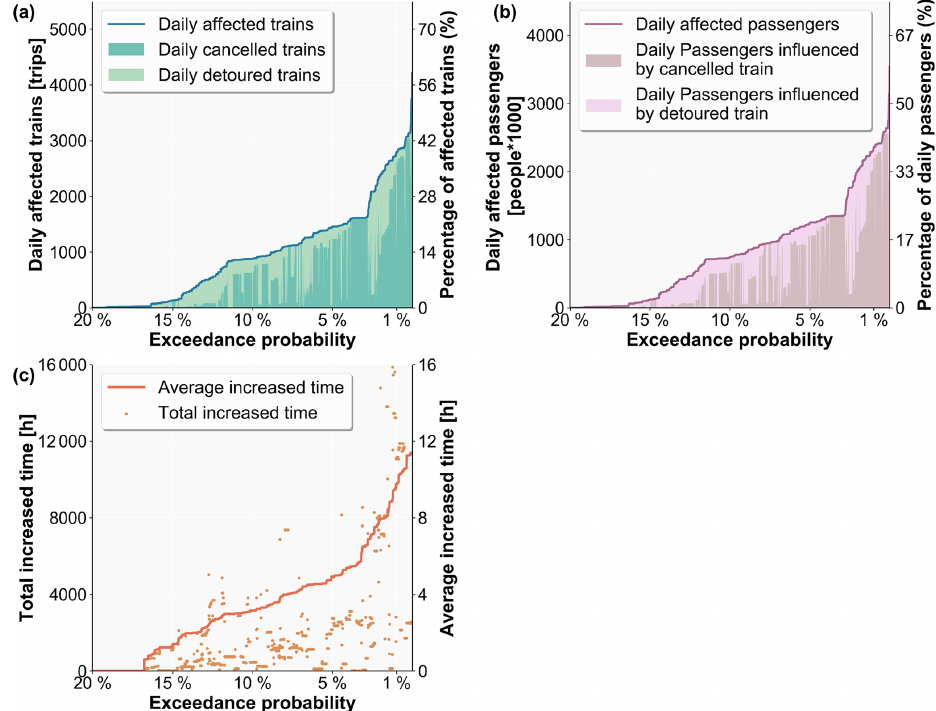
Figure 5. Exceedance probability–performance loss curves: (a) exceedance probability–affected trains curve, (b) exceedance probability– affected passengers curve, and (c) exceedance probability–increased time